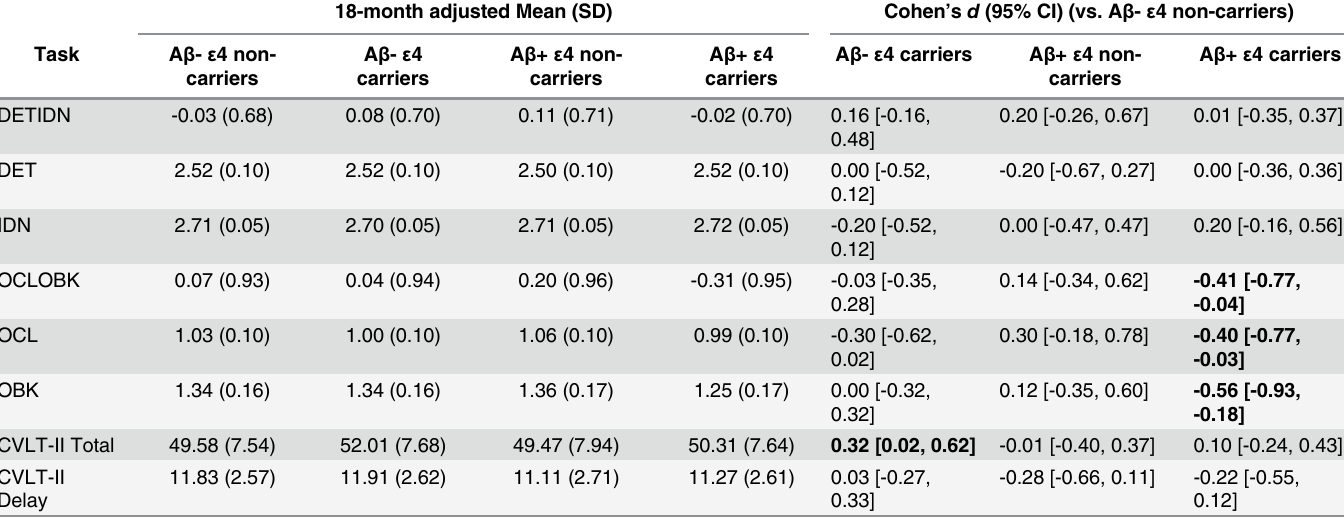
Table 2. Baseline and covariate adjusted mean scores at 18 months for each group and Cohen ’ s d of the difference in mean score change over 18 months, relative to the A β - ε 4 non-carrier group. Abbreviations: DETIDN, Psychomotor/Attention composite; DET, Detection task; IDN, Identification task; OCLOBK, Learning/Working Memory composite; OCL, One Card Learning task; OBK, One Back Learning task; CVLT-II Total, California Verbal Learn- ing Test, Second Edition, total recall; CVLT-II Delay, CVLT-II, 20 minute delayed recall. NOTE. Bolded values are significant at the p < .05 level. Means are adjusted for age, premorbid IQ, levels of anxiety symptoms, and baseline